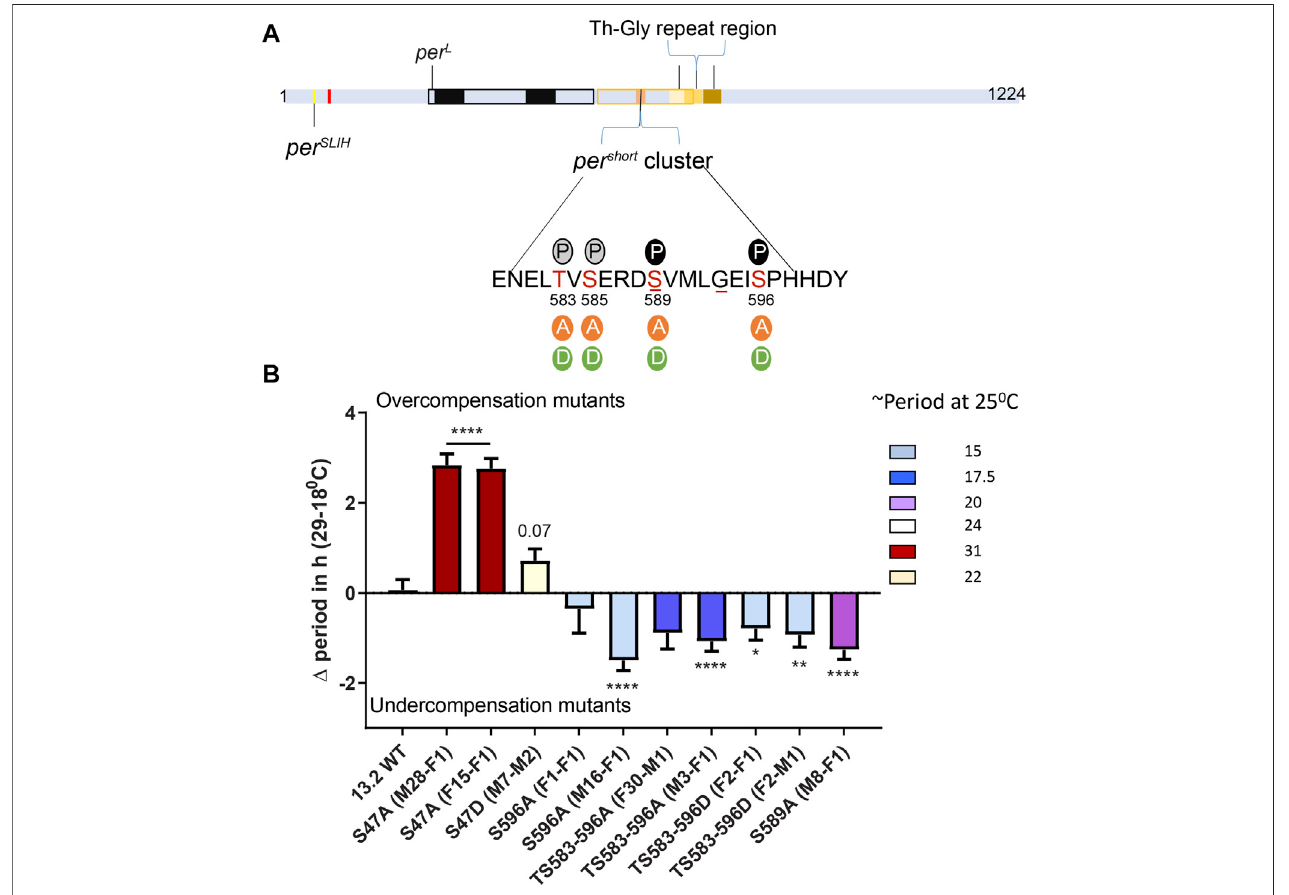
FIGURE 2 | The per s phosphocluster impacts temperature compensation. (A) PER schematic depicting the relative position of various mutants affecting temperature compensation,asshown in Figure1A .Themagni fi edregionshowskeySerineresidues ofthe per s phosphoclusterand thevarious substitutions thatwere tested. Solid P within black circle at 589 and 596 shows sites of DBT and NMO mediated phosphorylation, respectively. Grey circles show predicted phosphorylation sites at S585 and S583. Underlines at S589 and G593 denote positions of per s and per T mutant, respectively. (B) Graphical representation of the difference in period ofvariousmutantsofthe per s domainat29and18 ° C.Thecolorschemedenotesperiodofeachmutantlineat25 ° C.Allmutantsinthe per s domainproduceshort period phenotype at 25 ° C. Most show signi fi cant undercompensation. Transgenic lines with S47A recapitulated our observations with CRISPR-Cas9 genome editing ( Figure 1 ). Transgenic S47D showed a weaker phenotype than genome edited S47D, just short of statistical signi fi cance ( p = 0.07). Statistical signi fi cance was calculated using two-way ANOVA with Sidak ’ s multiple comparison